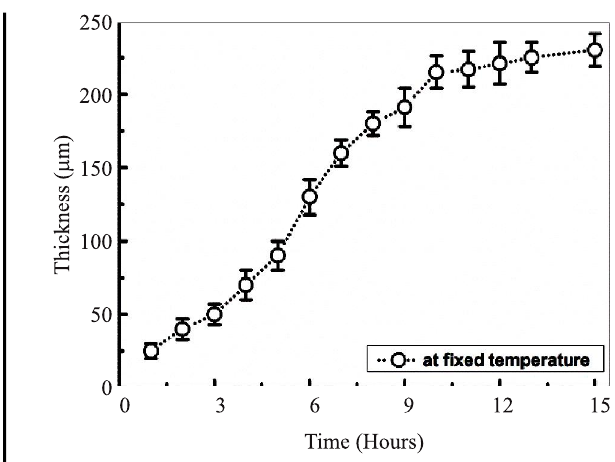
FIG. 4. THE DATA THAT WAS OBTAINED AT DIFFERENT TEMPERATURES TO MEASURE THE